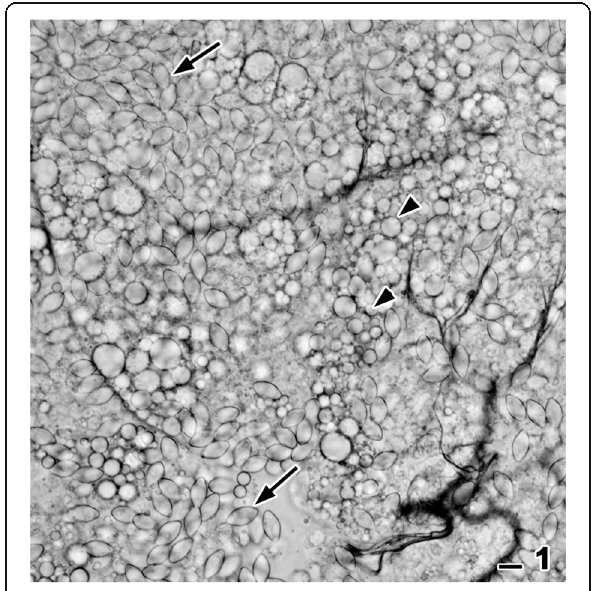
Fig. 1 Fresh oocysts of Mattesia dispora from Ephestia kuehniella . The arrows indicate oocysts and the arrowheads lipid droplets in the heavily infected fat body. Bars, 10 μ m